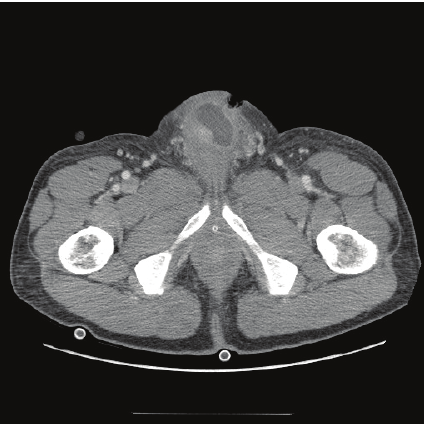
Figure 1: Contrast CT scan of the pelvis of Case 1. CT scan showed abscesses within or adjacent to the bilateral corpus cavernosa. The largest abscess was located in the left corpus cavernosum, measuring 4.8 × 2.8 × 4.4cm. The additional left corpus cavernosum and right corpus cavernosum abscesses measured 2.4 cm and 1.6 cm, respectively, in longest diameter on coronal views.